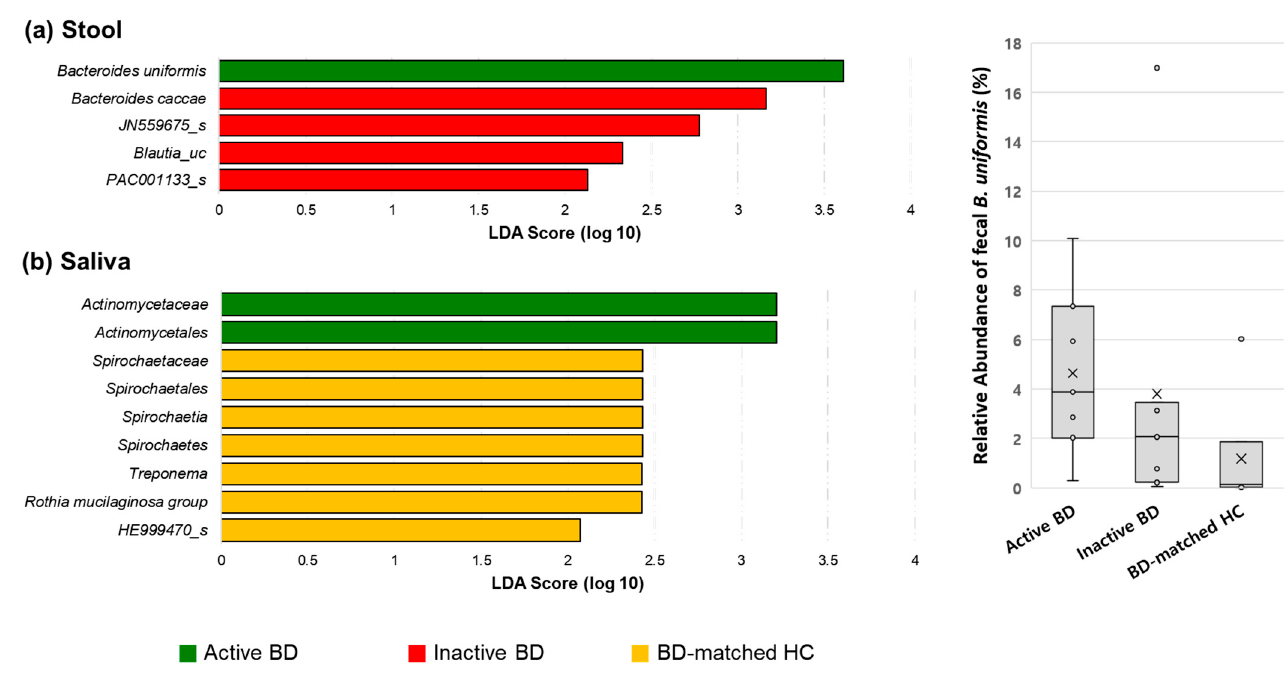
Figure 8. Relative abundances of taxonomic compositions of microbiomes of stool ( a ) and saliva ( b ) in active BD (green), inactive BD (red), and BD-matched HC (yellow) groups. The linear discriminant analysis (LDA) scores (log 10) were calculated using the LDA Effect Size (LEfSe) algorithm by comparing these three groups at once. The abundance of fecal Bacteroides uniformis was significantly different between the active BD, inactive BD, and BD-matched HC groups ( p = 0.042), and was the highest in the active BD group. However, a minor difference in the relative abundances in the salivary microbiomes between groups was observed, and significantly different abundances of microbes were not detected in the fecal microbiomes of the BD-matched HC and the salivary microbiomes of the inactive BD group. BD, Behçet’s disease; HC, healthy control.